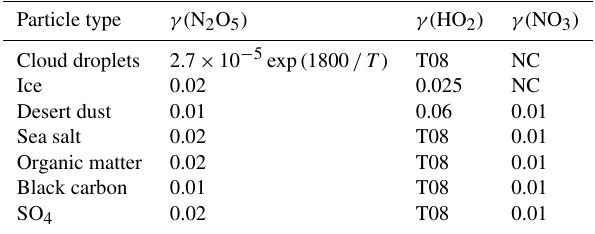
Table 3. Heterogeneous γ values used for prescribing conversion rates on atmospheric cloud droplets, ice and aerosols. “T08” refers to Thornton et al. (2008) and “NC” indicates not